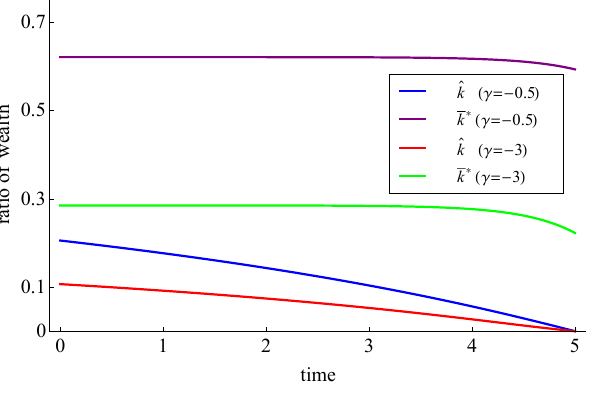
Figure 2. Optimal pre- and post-crash strategies for ρ = − 0 . 5